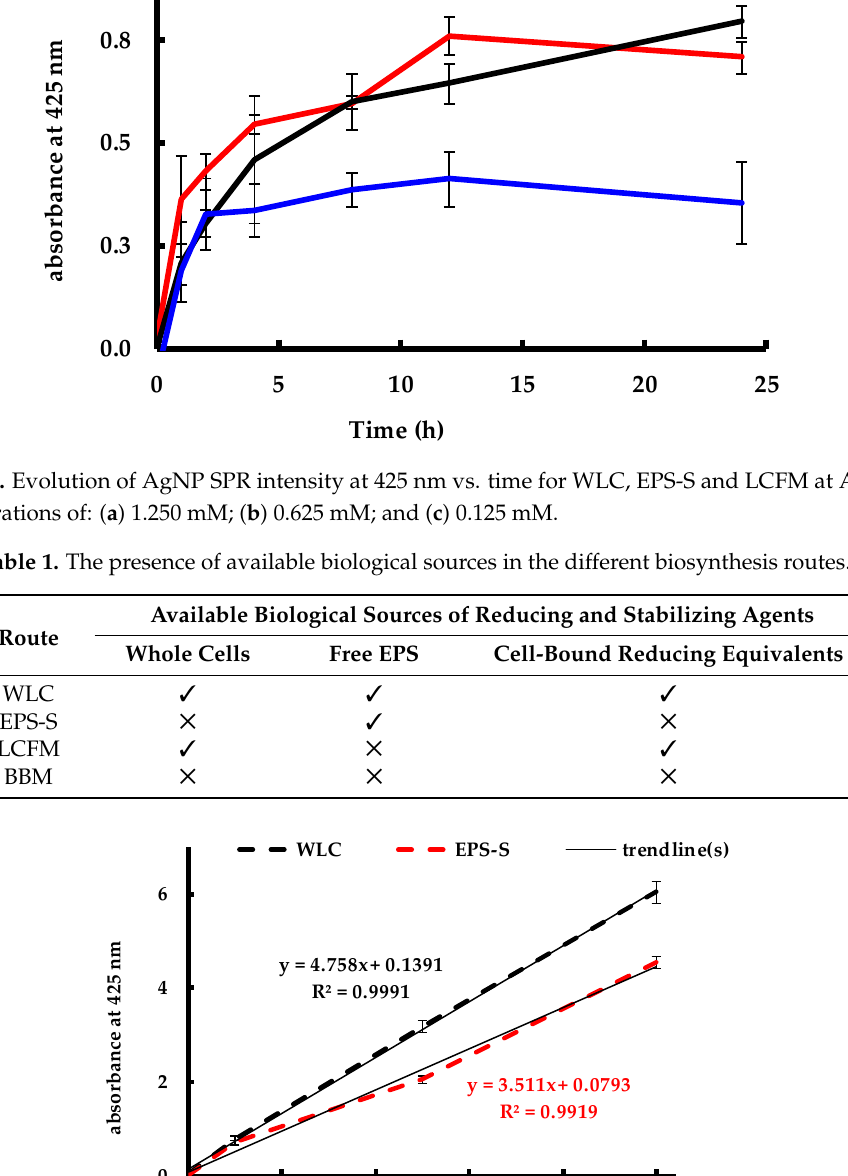
Figure 4. Dependence of maximum stabilized AgNPs as a function of AgNO 3 input.